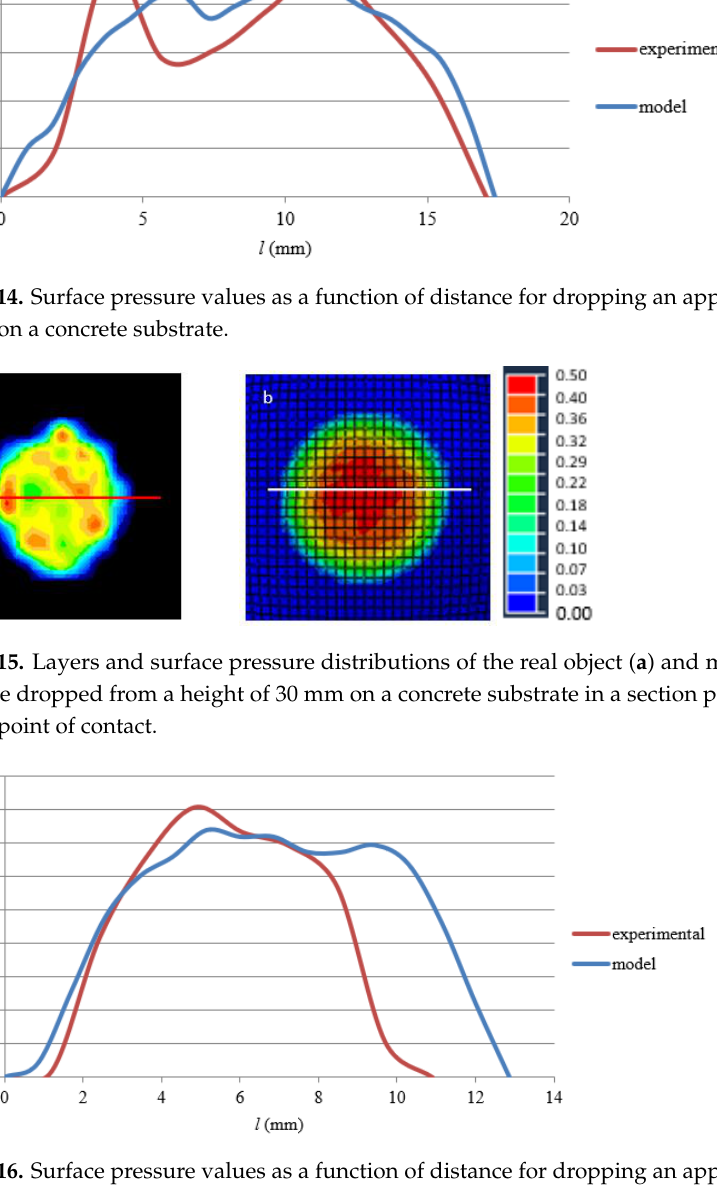
Figure 17. Layers and surface pressure distributions of the real object ( a ) and model object ( b ) for an apple dropped from a height of 10 mm on a wooden substrate in a section passing through the central point of contact. Figures 18 and 19a,b present the courses of values of surface pressures as functions of distance for the drop, from the height of 30 mm on the wooden substrate, as well as drawings of contour lines and distributions of surface pressures of the real and model objects, in the cross-section passing through the central point of contact. For drops from a height of 30 mm, Komarnicki et al. [36] found the damage, as evidenced by the shift of maximum surface pressures from the central zone to the peripheral zone of the contact area. In the analysed case, the surface pressure values, as opposed to a drop from a height of 10 mm, reached similar values. In the course of the maximum values of surface pres- sures in the cross-section passing through the central point of contact, a decrease of these